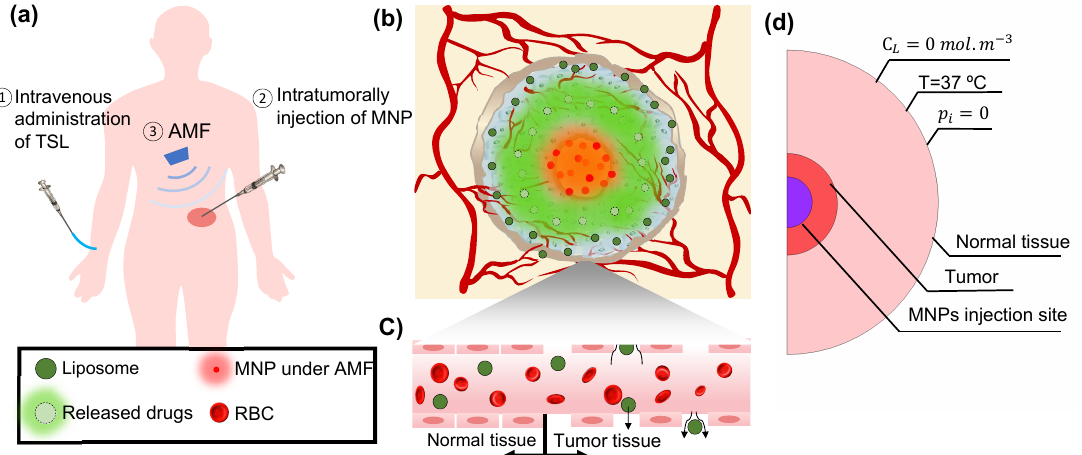
Figure 1. TSL-Dox delivery combined with MHT. ( a ) Schematic illustration of realizing the sug- gested combination therapy. The two nanoparticles have different localization: TSLs are injected intravenously and enter the tumor tissue through blood vessels. MNPs are injected intratumorally at the tumor core. MNPs increase tumor temperature when exposed to AMF. ( b ) The generated heat inside the tumor causes both cell death by heat and drug release from TSLs. Treatment outcomes of the proposed combination therapy depend on an acceptable concentration of released drug and temperature profile. ( c ) Due to the small vessel pore diameter in the healthy tissues, TSLs cannot pass through the vessel wall, and they mainly enter the tumor interstitial space. ( d ) The model geometry and boundary